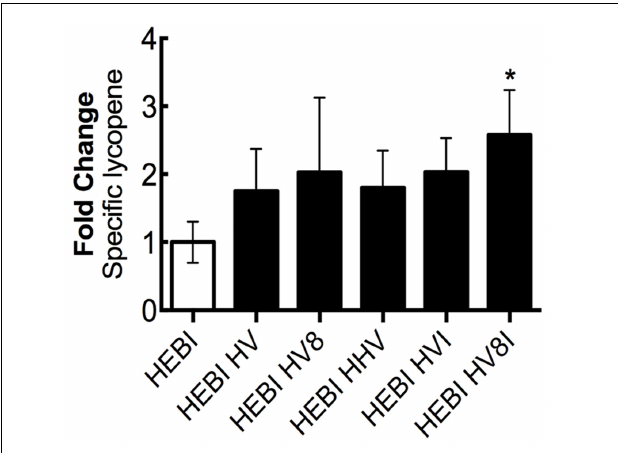
FIGURE 9 | Lycopene production in fed-batch shake flask cultures. Strains were grown for 12 days in 25 mL of YPD10 at 30 ◦ C in baffled shake flasks with glucose feeding as described. Bars and error bars represent the mean and standard deviation, respectively, of biological triplicates. HEBI strain. All of the triple and double integrations produced similar specific lycopene contents, indicating that the quadruple integrant had a synergistic effect to maximize flux to